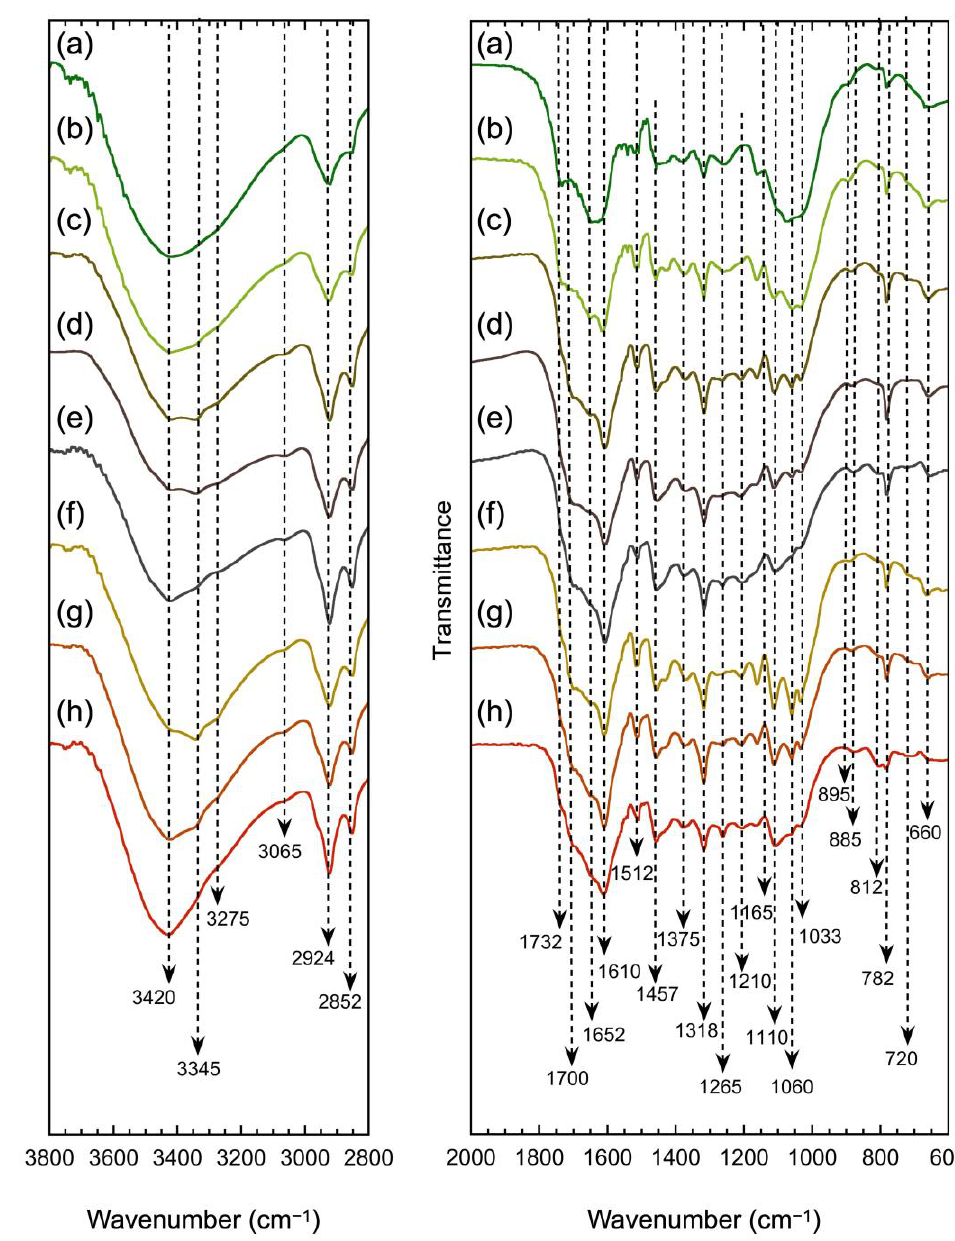
Figure 1. FTIR spectra of FS ( a ) and hydrochar samples HTC_25_180_30 ( b ), HTC_25_250_30 ( c ),